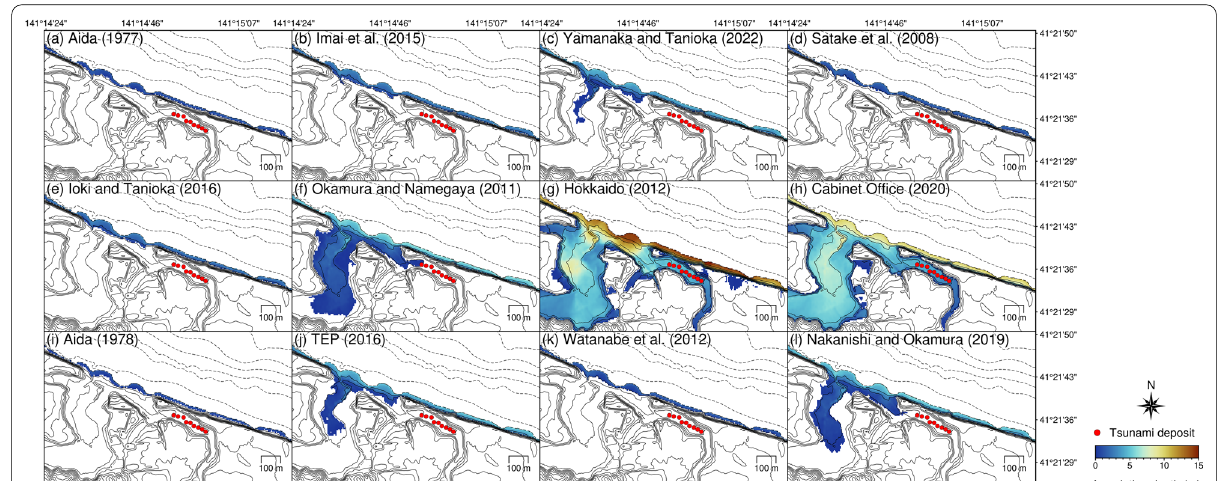
Fig. 6 Computed inundation area at Sekinehama using fault models by previous studies. Comparison computed inundation area using previously proposed fault models (Fig. 3 and Table 2) with tsunami deposit distribution at Sekinehama: a 1611 CE Keicho tsunami model by Aida (1977), b 1611 CE Keicho tsunami model by Imai et al. (2015), c 1611 CE Keicho tsunami model by Yamanaka and Tanioka (2022), d seventeenth-century tsunami model by Satake et al. (2008), e seventeenth-century tsunami model by Ioki and Tanioka (2016), f seventeenth-century tsunami model by Okamura and Namegaya (2011), g Hokkaido Disaster Prevention model (2012), h Cabinet Office (2020) model (Case 2), i 1968 CE Tokachi-oki tsunami model by Aida (1978), j 1968 CE Tokachi-oki tsunami model by TEP (2016), k submarine active fault model by Watanabe et al. (2012), and l 1640 CE Mt. Komagatake eruption tsunami model by Nakanishi and Okamura (2019). The red circles show the sites where tsunami deposits possibly formed in the fifteenth to seventeenth century, found by Ishimura et al. (2022). The solid contour shows the topography, and the dotted contour shows the bathymetry (less than 0 m), and these contour intervals are 2